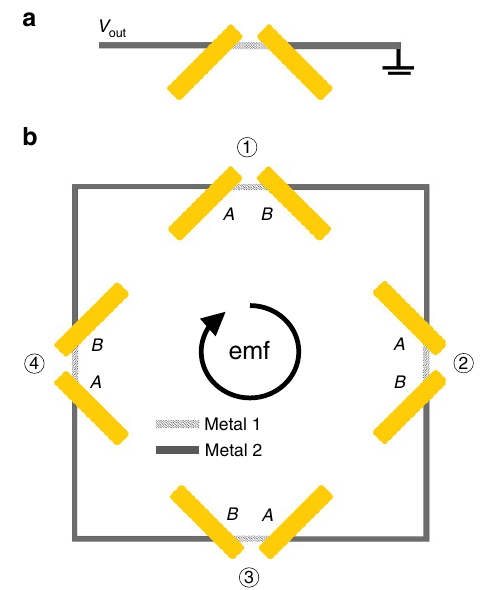
Figure 2 | Antenna-coupled thermopile for light ellipticity detection. ( a ) Dimer-antenna-based thermocouple to discriminate between LCP and RCP light. ( b ) The design of the antenna-coupled thermopile element for the detection of S 3 Stokes parameter of light. result, the LCP (RCP) light produces heating only in the left (right) rod antenna as shown in Fig. 1c. If a thermocouple is now placed in thermal contact with the antennas, as shown schematically in Fig. 2a, the temperature difference between the thermocouple junctions will be translated into the d.c. voltage